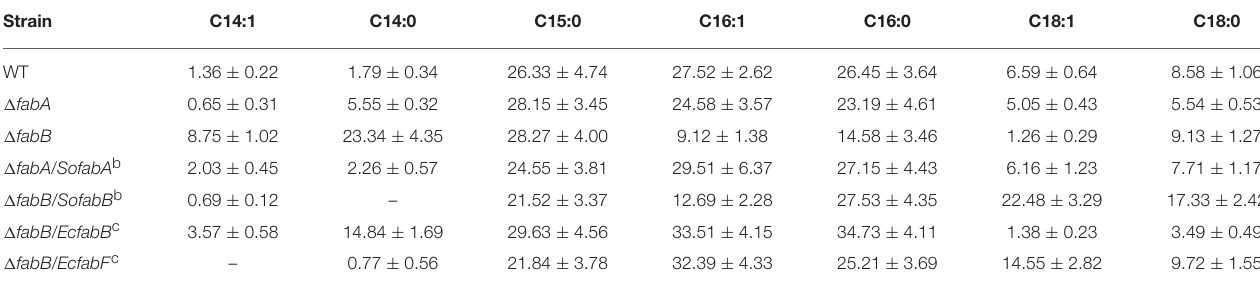
TABLE 3 | Fatty acid composition of S. oneidensis strains a . Strain C14:1